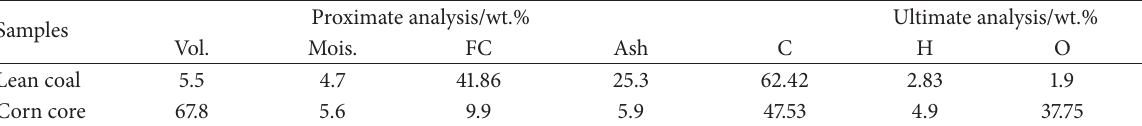
Table 1: Proximate and ultimate analyses of biomass and coal.